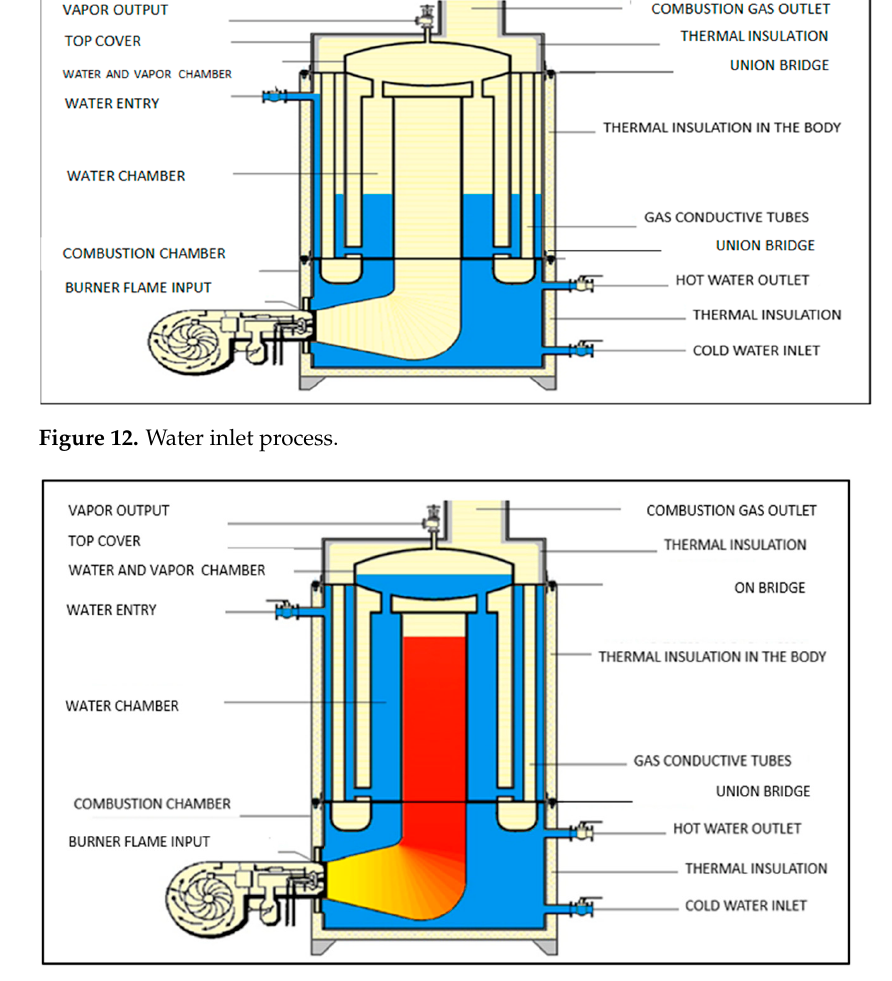
Figure 13. The ignition chamber surrounded by water and the water chamber is at its maximum level (blue color), and the burner is on, and the combustion gases are making their first run.